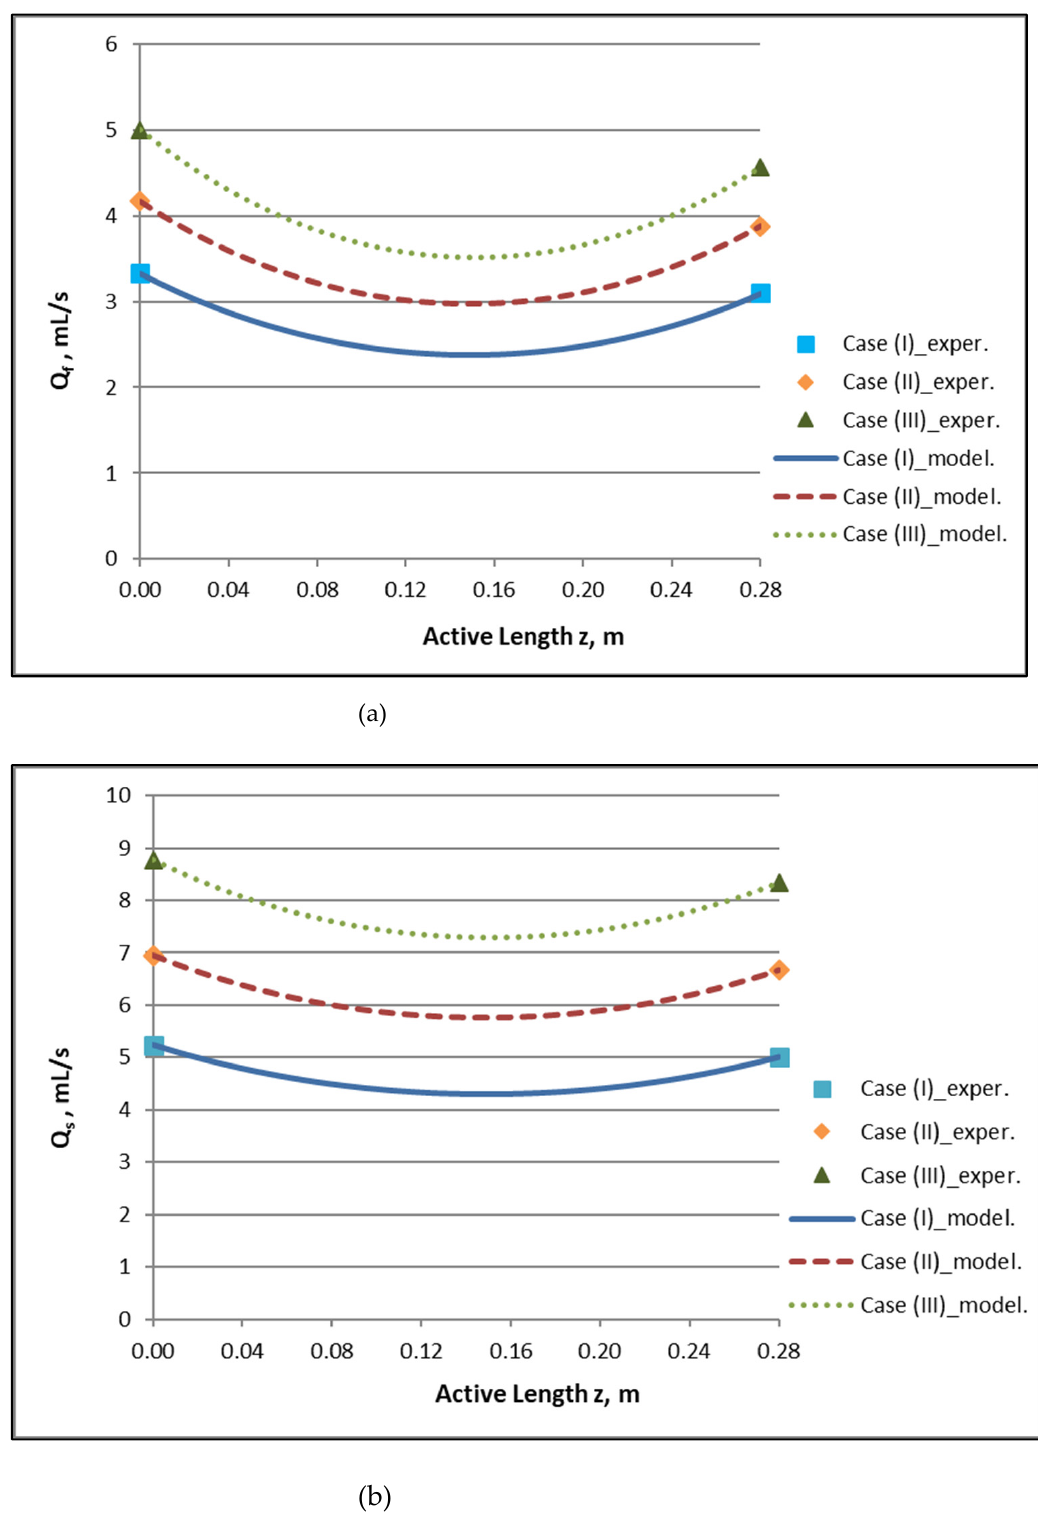
Figure 4. Predicted axial variation of: ( a ) lumen-side flow rate Q f /Q Blood and ( b ) shell-side flow rate Q s /Q Dialysate for the three cases studied. Case (I): Q Blood /Q Dialysate : 200/300 mL/min. Case (II): Q Blood /Q Dialysate : 250/400 mL/min. Case (III): Q Blood /Q Dialysate : 300/500 mL/min. Data points ( , , ▲ ) designate imposed/measured inlet flow rates.